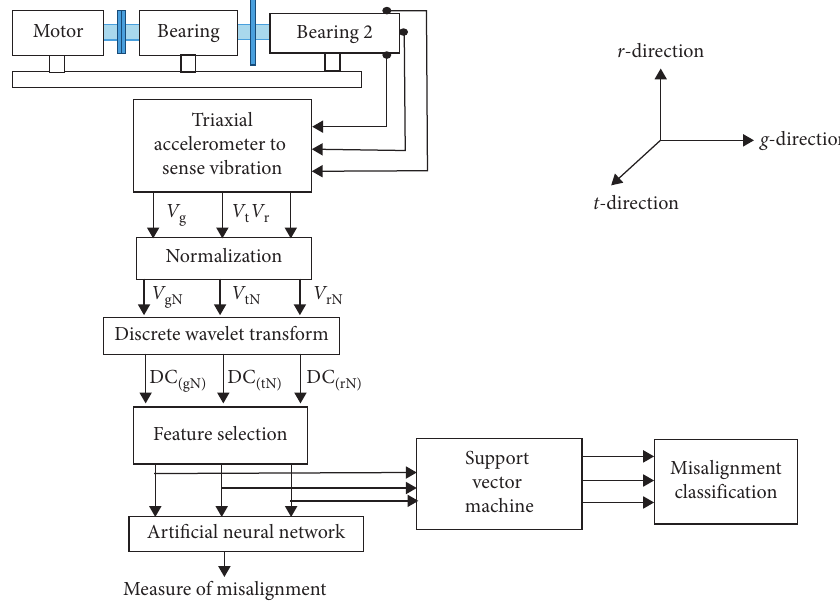
Figure 1: SVM- and ANN-based misalignment prediction.